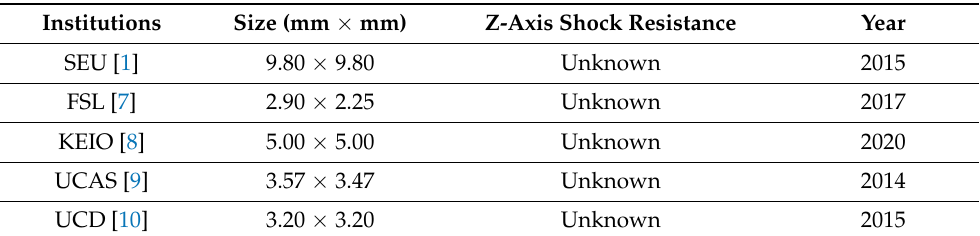
Table 1. Comparison with a previously reported 3-axis gyroscope.